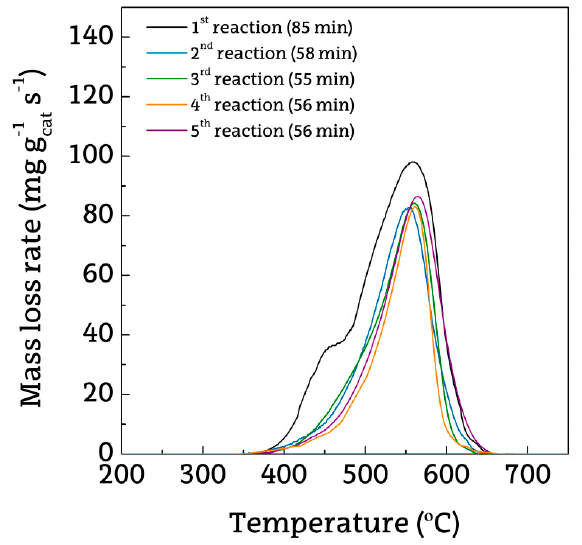
Figure 4. TPO profiles of the catalysts deactivated in the reaction steps in five consecutive reaction- regeneration cycles.